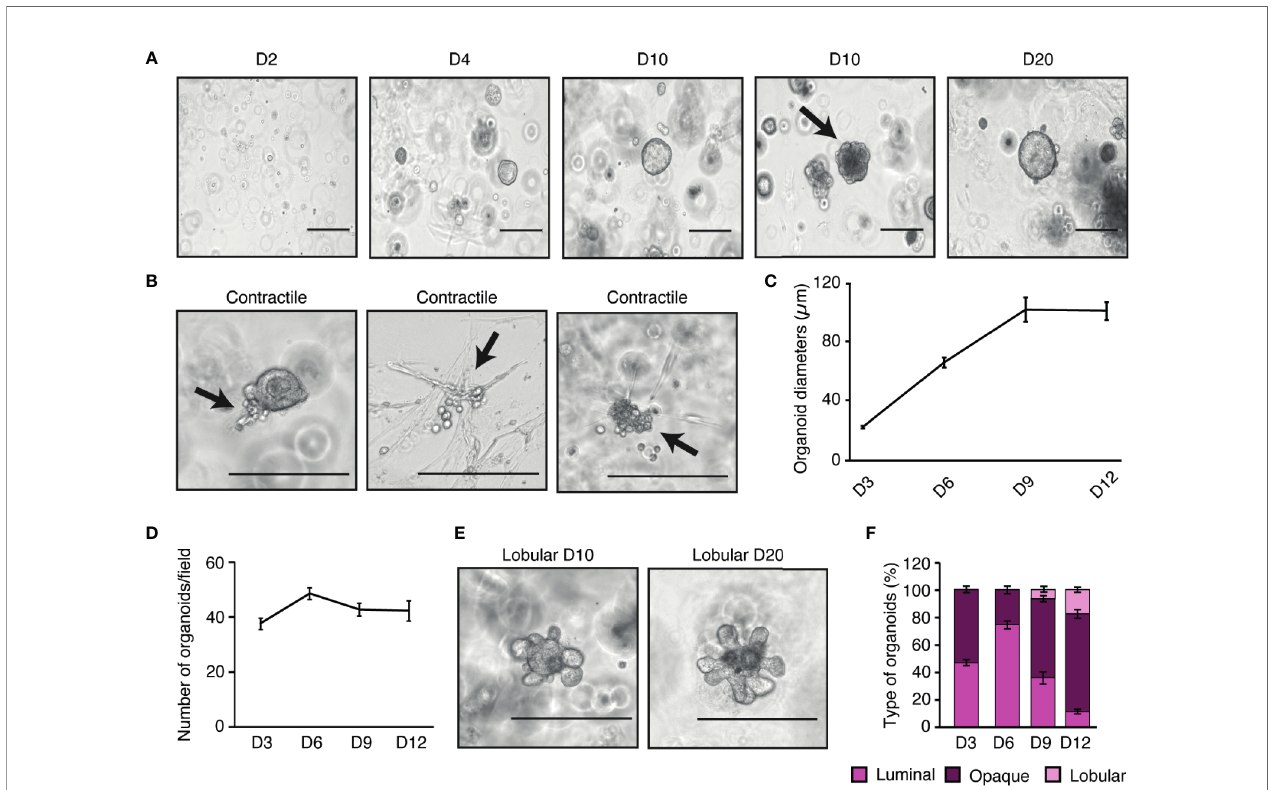
FIGURE 3 | Ex vivo mammary epithelial cell organoids recapitulate the in vivo architecture of the mammary gland. (A) Bright fi eld visualization of organoids over 20 days in three-dimensional culture. At 10 days, spheroid-like organoids can be observed along with the beginning of lobular structures (black arrow). (B) Contractile structures are indicated by black arrows (see videos in Supplemental Figure S1 to observe contractions). (C) Diameter measurements of organoids over time (45 organoids measured/day). (D) Number of visible organoids through time in three-dimensional culture. (E) Bright fi eld visualization of lobular organoids after 10 and 20 days in three-dimensional culture. (F) Percentage of luminal, opaque, and lobular organoids over time. For (C, D, F) , results are shown as mean ± SEM of one out of three independent experiments. Scale bars = 300 m m for (A, B, E)